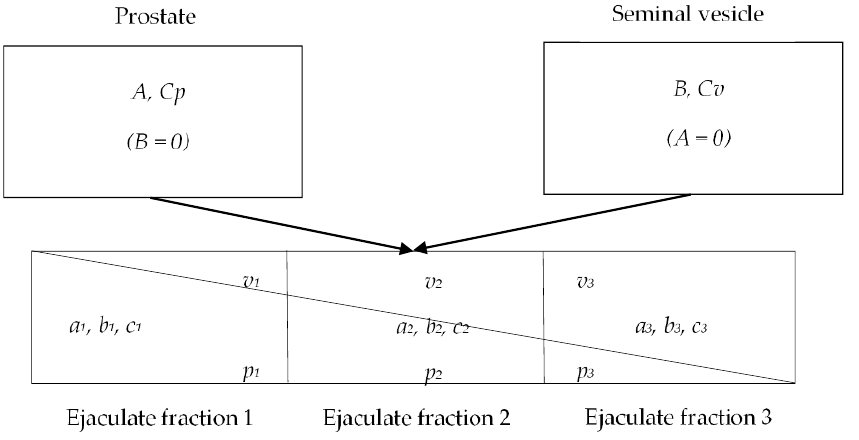
Figure 1. Schematic representation of split-ejaculate calculations based on prostate and seminal vesicle contributions to semen. A : concentration of PSA in prostatic secretions (calculated), a j : concentration of PSA in fraction j of seminal plasma (measured), B : concentration of fructose in seminal vesicle secretions (calculated), b j : concentration of fructose in fraction j of seminal plasma (measured), v j : proportion of seminal vesicle secretion in fraction j of seminal plasma (calculated), C P : concentration of fosfomycin in prostate (calculated), C V : concentration of fosfomycin in seminal vesicles (calculated) and c j : concentration of fosfomycin in the fraction j of seminal plasma (measured).